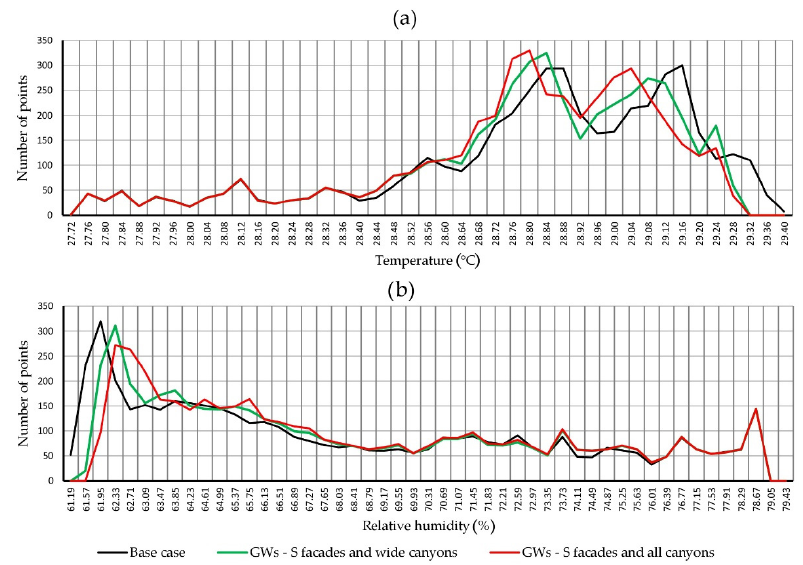
Figure 11. Distribution of the number of points in the modelled grid, related to the external air temperature (°C) ( a ) and the relative humidity (%) ( b ) considering the base case and the two configurations for the green walls GW.1 and GW.2 in district M2.